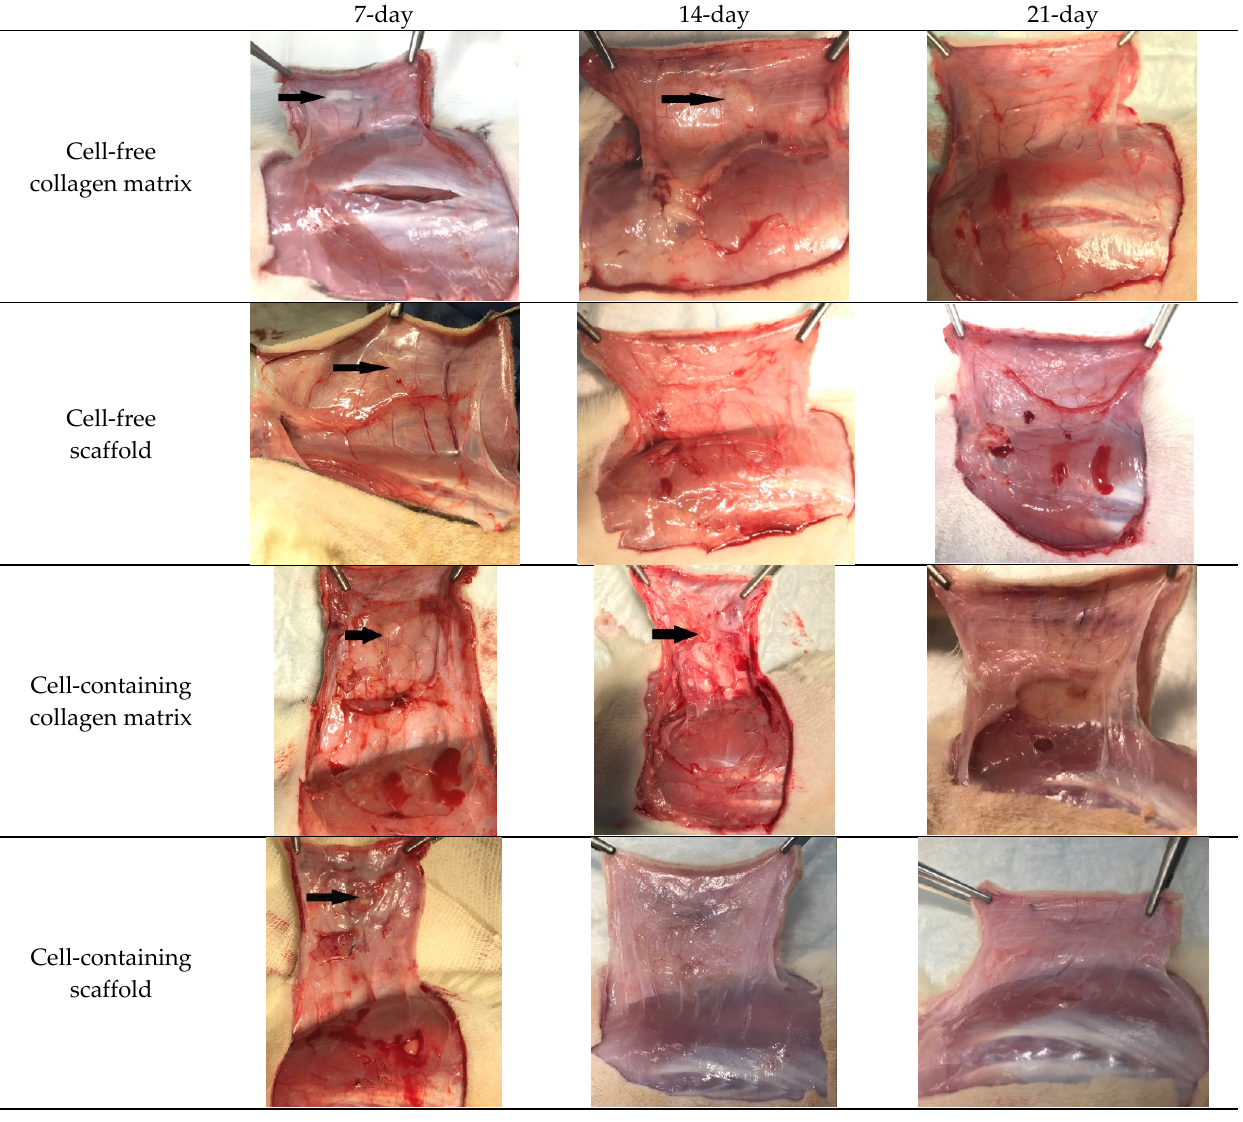
Figure 3. Appearance of the implantation area when material was taken. Note: The black arrows indicate implant fragments visible to the naked eye in the animal tissue structure.